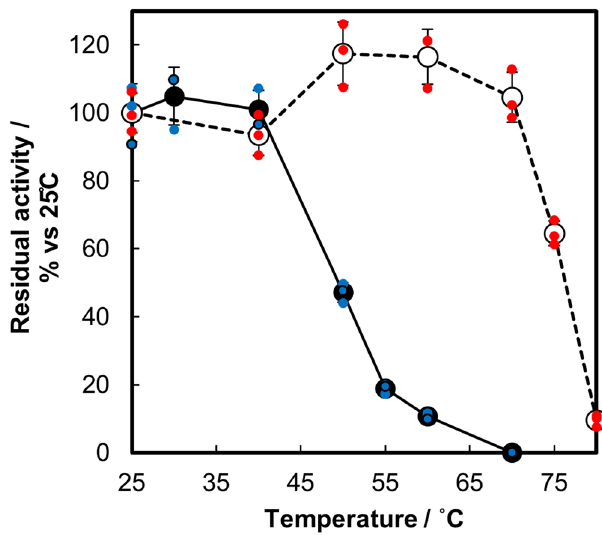
Fig. 3 Thermal stability of the quaternary structure engineered BcGDH. Temperature dependence on residual enzymatic activity after 15 min. incubation is plotted. Mean values of residual activity are plotted as black closed circle and open circle for control (BcGDH without disul fi de mutation) and α P205C/ β D383C- γ K155C/ β Y349C mutant BcGDHs, respectively. ( n = 3, value ± SD) Data points for control enzyme or mutant enzyme are shown in blue or red small circles, respectively. Numerical Data for Fig. 3 can be found in Supplementary Data Fig. 2a; uncropped and unedited gel images are shown in Supple- mentary Fig. 2b, Supplementary Table 3) exhibited a k cat value of